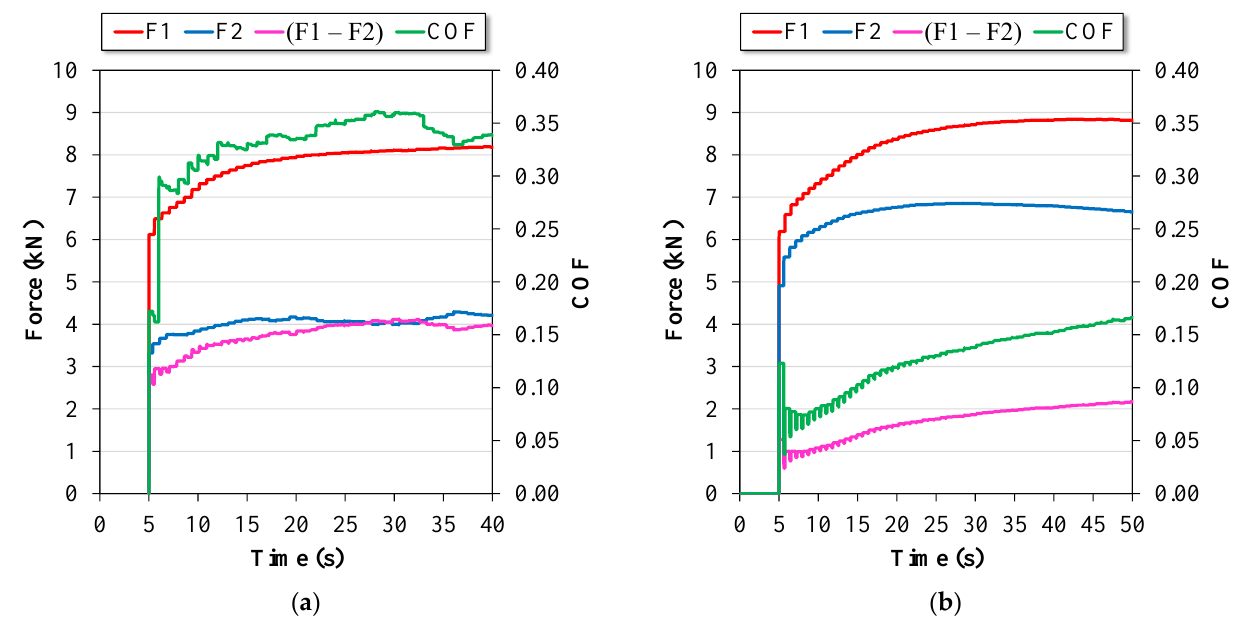
Figure 8. Characteristic curves of the acting forces and COF under the following test conditions: pin roughness Ra = 0.54 µm, relative elongation 𝜀 𝑟 = 0.06, strip orientation: 0°, lubricated condition. ( a ) BUT test; ( b ) STT test. ( 𝐹 1 − 𝐹 2 ) is the difference between the forces acting on each side of the metallic strip .